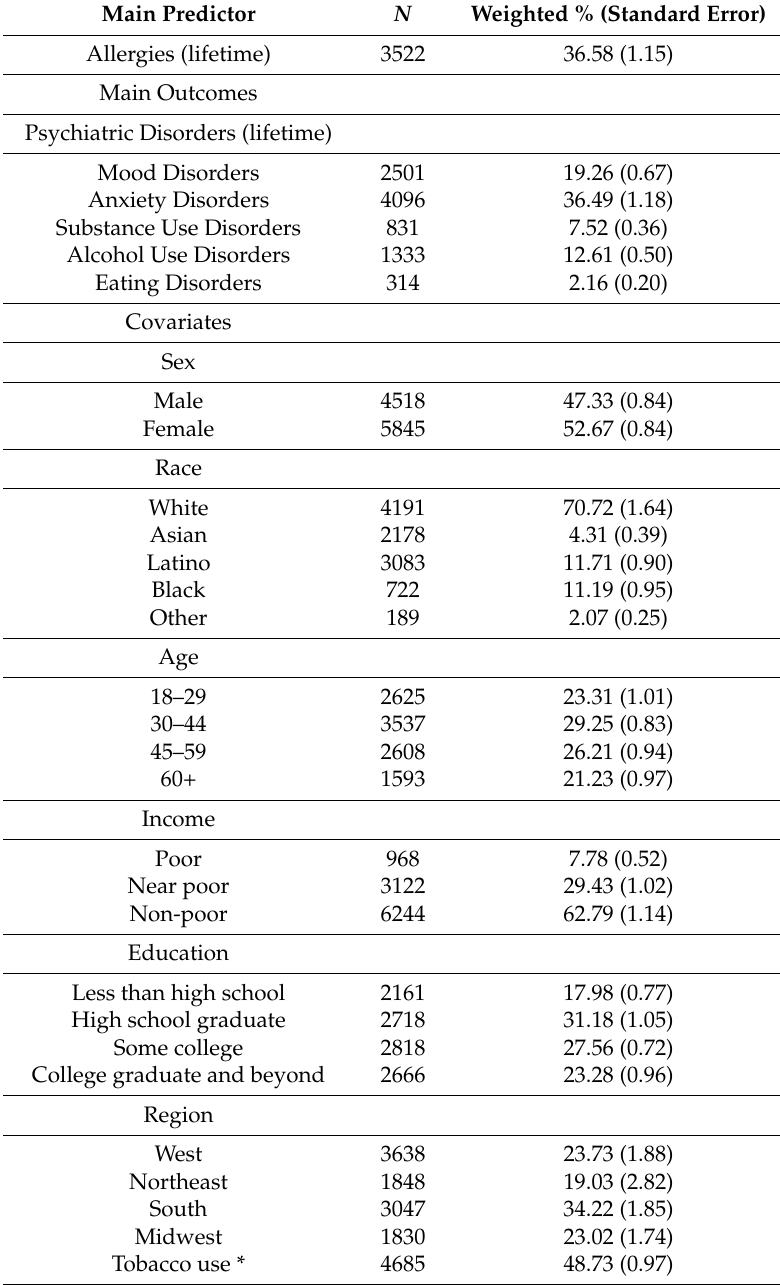
Table 1. Analytic sample characteristics of the NCS-R and NLAAS (United States, 2001–2003) ( N =